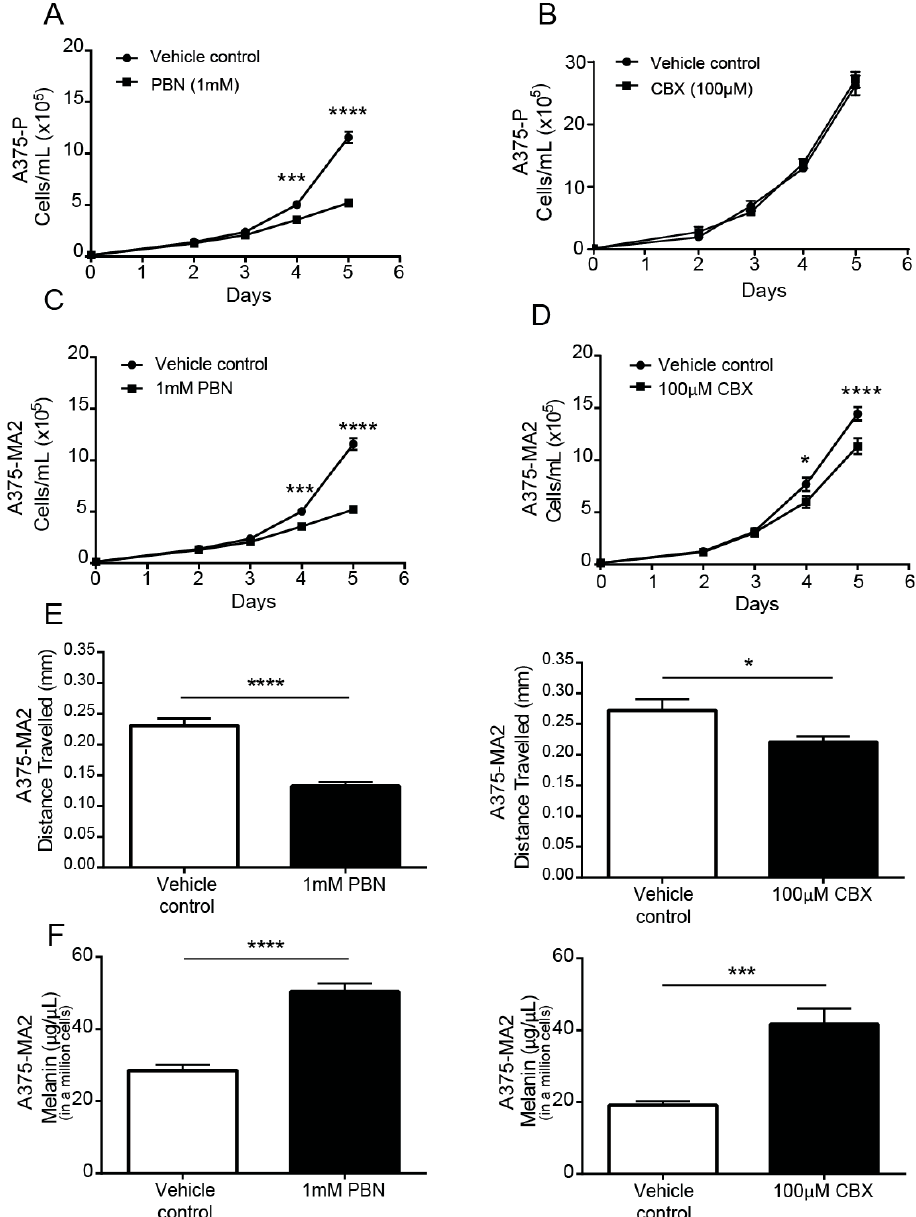
Figure 5. PANX1 blockers reduce the tumorigenic properties of human melanoma cells in vitro. A375-P melanoma cells were cultured at 20,000 cells per well in medium containing 10% FBS in the presence of PBN (1 mM) in ( A ) and CBX (100 μ M) in ( B ). Similarly, A375-MA2 melanoma cells were cultured in the presence of PBN ( C ) or CBX ( D ) added to the culture medium. Cells were counted daily up to 4 days after initial seeding of the cells onto the culture. The data are expressed as mean ± SEM from three separate experiments conducted with three technical replicates. (N = 3, n = 9). ( E ) Scratch assays were performed on a confluent monolayer of A375-MA2 cells in the presence of PBN (1 mM, N = 3, n = 22) or CBX (100 μ M, N = 3, n = 20) to assess migration. Data are expressed as mean ± SEM. Vehicle treated cells were used as control in the experiment. A significant decrease in A375-MA2 cell migration was noted in the presence of PBN and CBX. ( F ) Significantly more melanin was extracted from A375-MA2 cells treated with either 100 μ M CBX (N = 3, n = 15) or 1 mM PBN (N = 3, n = 13) compared to vehicle controls. Statistical analyses for growth curves were performed using a two-way ANOVA followed by a Sidak test. Statistical analyses for migration assays and melanin extraction data includes student’s t -tests; * p < 0.05, *** p < 0.001, **** p < 0.0001; Bars indicate SEM.